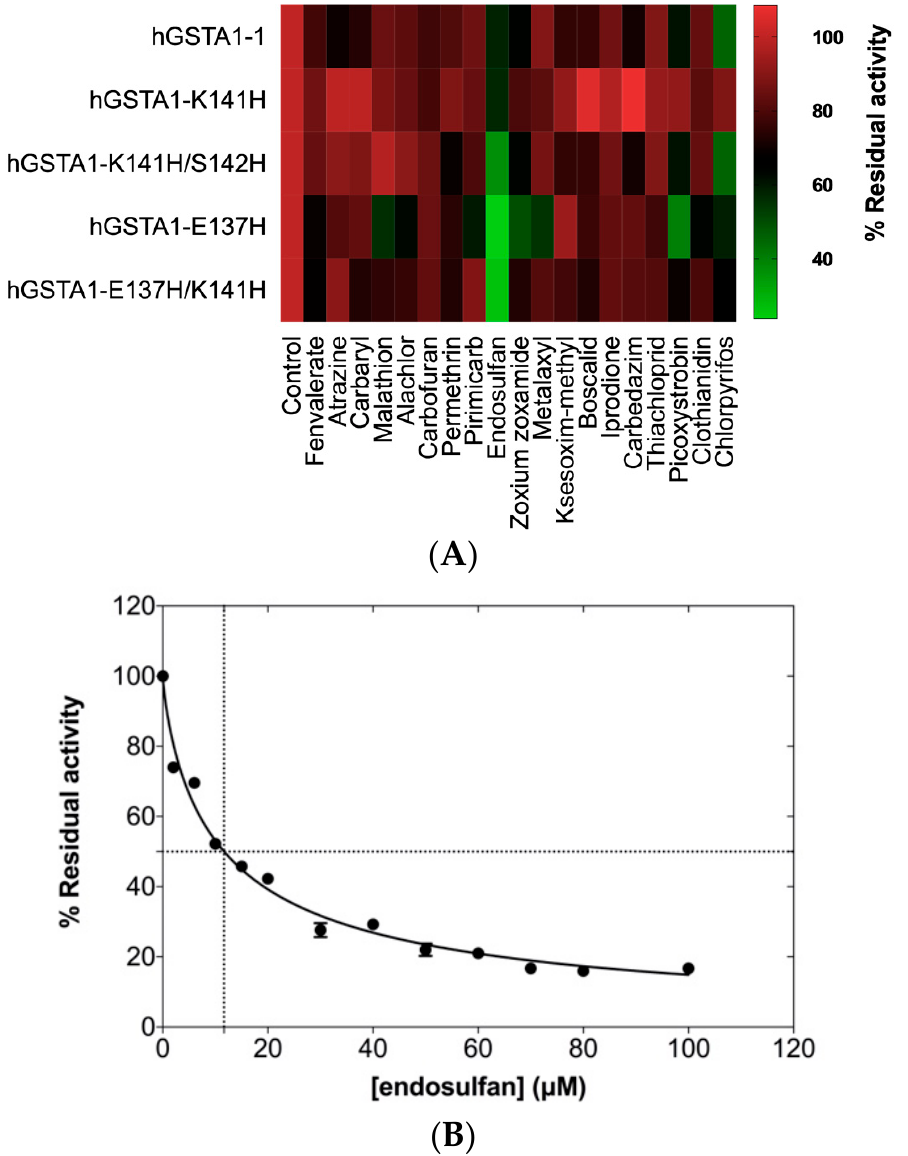
Figure 6. ( A ) Screening of inhibition potency of selected pesticides (25 µ M) against the wild-type enzyme and its mutants. The inhibition was evaluated by measuring GST catalytic activity using GSH-CDNB as substrate system, in the presence of 25 µ M of pesticide for a period of 2 min. In the absence of pesticides, enzyme activity was taken as 100%. Experiments were performed in triplicate, and the reported values in the heat map correspond to the mean value. ( B ) Concentration–response curve for endosulfan. IC50 value for hGSTA1-K141H/S142H was determined using GraphPad Prism. GST activity was assayed using the CDNB–GSH assay system in triplicate (standard errors are